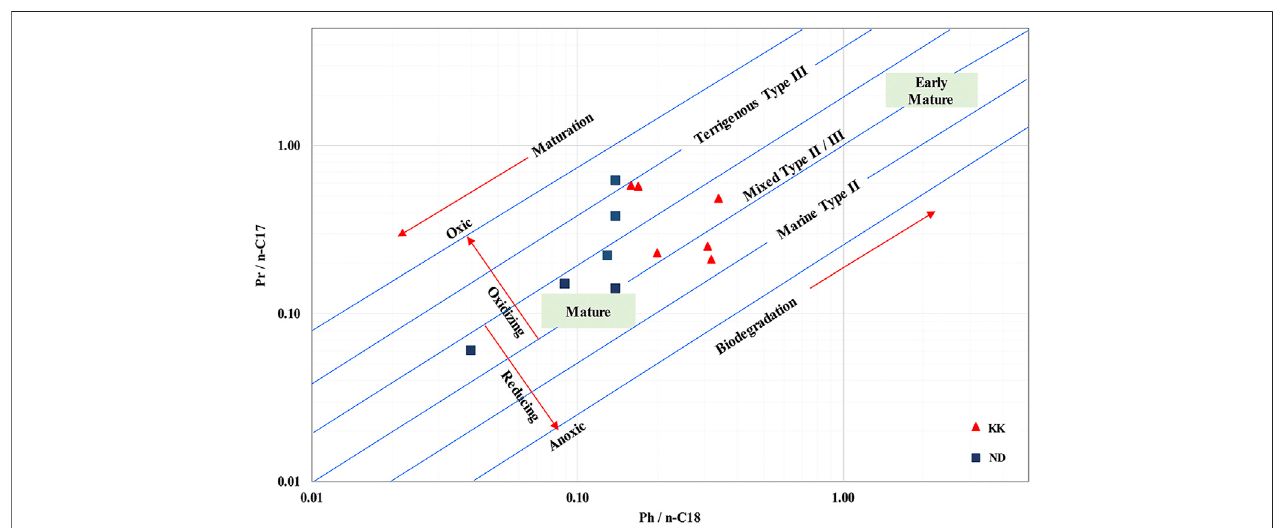
FIGURE7| TernarydiagramofrelativeabundanceofC 27 ,C 28 andC 29 regularsteranesshowsorganicmattersourceanddepositionalenvironmentofthesamples from the Khao Khwang (KK) and Nam Duk (ND) Formations.